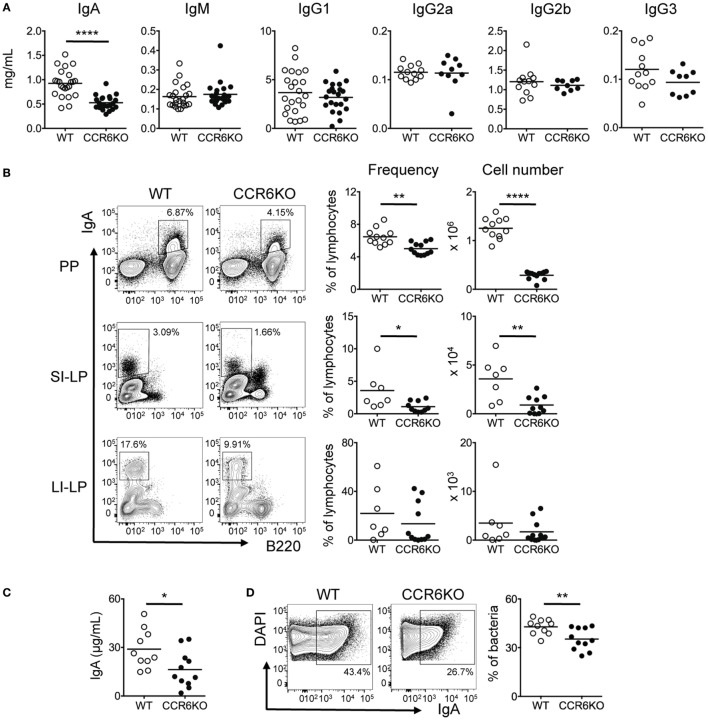
CCR6−/− mice show reduced IgA production. (A) Sera from WT and CCR6−/− littermates were analyzed for immunoglobulin subtypes using ELISA. (B) Lymphocytes isolated from Peyer’s patches (PPs), SI-LP, and LI-LP were subjected to FACS analysis of surface IgA and B220. The frequency and absolute number of IgA-bearing cells are shown. (C,D) Mouse feces were collected from the cecum, weighed, and homogenized in PBS-containing protease inhibitors. The homogenates were subjected to consecutive centrifugations to separate bacteria from bacteria-free supernatants. Bacteria-free supernatants were subjected to the analysis of IgA with ELISA (C). Cecal bacteria were subjected to FACS analysis of IgA-coated bacteria (D). Each symbol represents one mouse. Data are a compilation of three to five (A) or three independent experiments (B–D) (*p < 0.05; **p < 0.01; ****p < 0.0001).